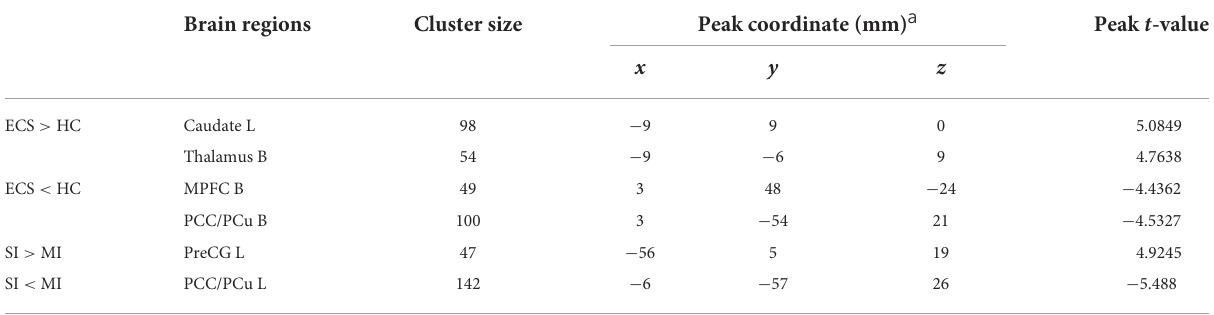
TABLE 3 Brain regions with ALFF differences in ECS and HCs and in ECS cognitive subtypes. Brain regions Cluster size Peak coordinate (mm) a Peak t -value x y z